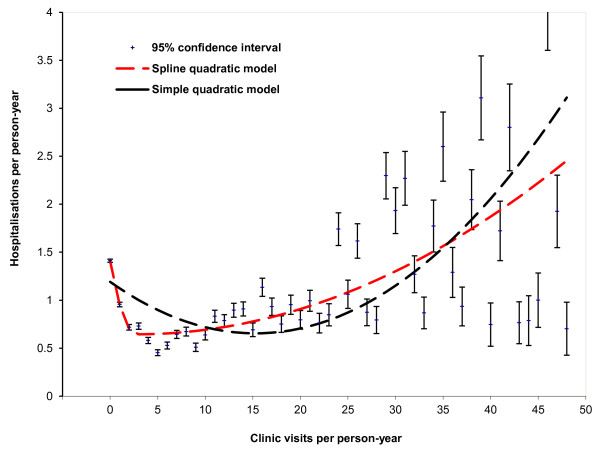
Average hospitalisations per person-year by average annual clinic visits for remote Indigenous patients with 95% confidence intervals, comparing two quadratic models, Northern Territory, Australia, 2007–2011.